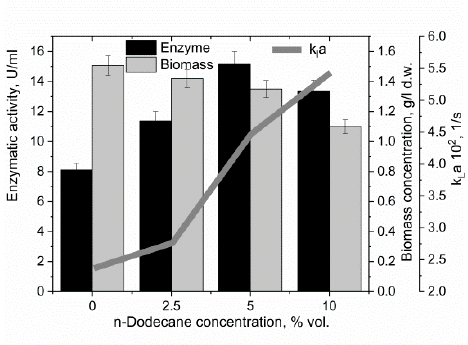
Figure 5. Variation in α -amylase activity and A. terreus biomass concentration with n -dodecane volumetric fraction on the third day of fermentation (pH = 6).